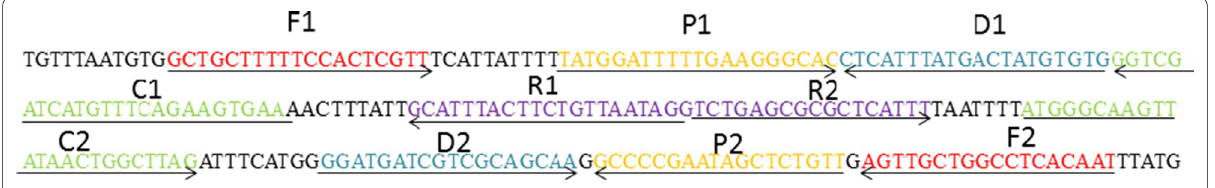
Fig. 1 Schematic diagram of MCDA primer design for pgaD